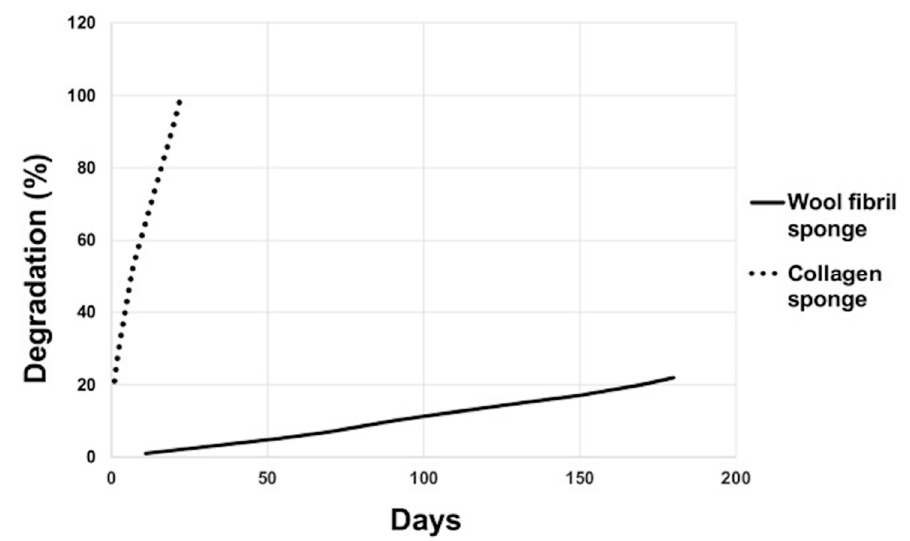
Figure 7. Degradation rate of the commercial collagen sponge vs. wool fibril sponge.